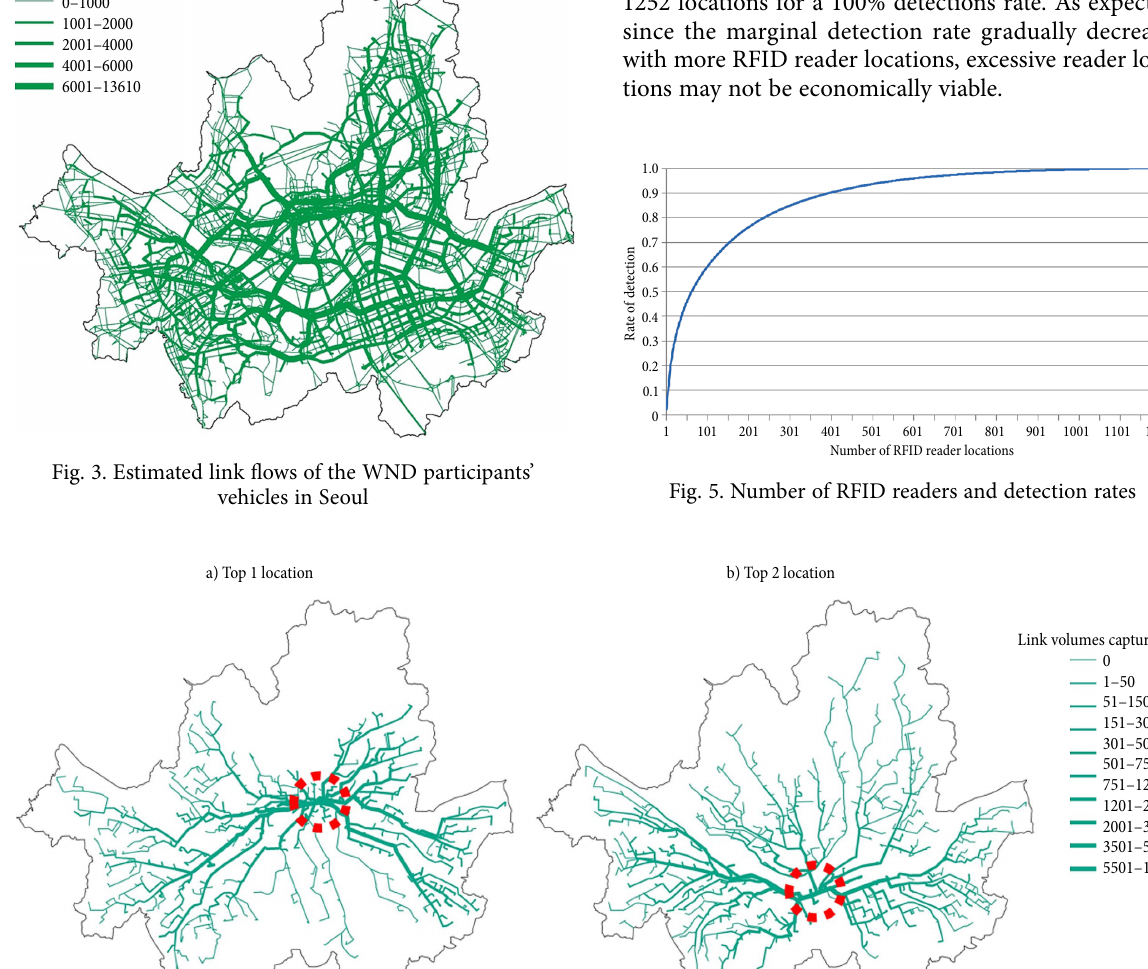
Fig. 4. Top 2 locations that capture the most flows